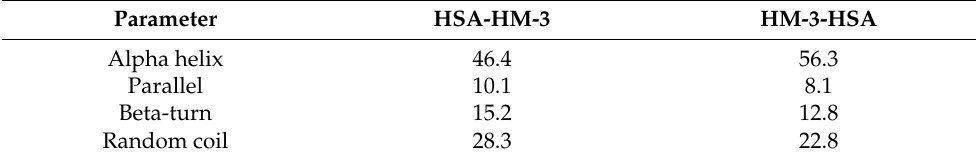
Table 2. Comparison of secondary structures of HSA-HM-3 and HM-3-HSA *.